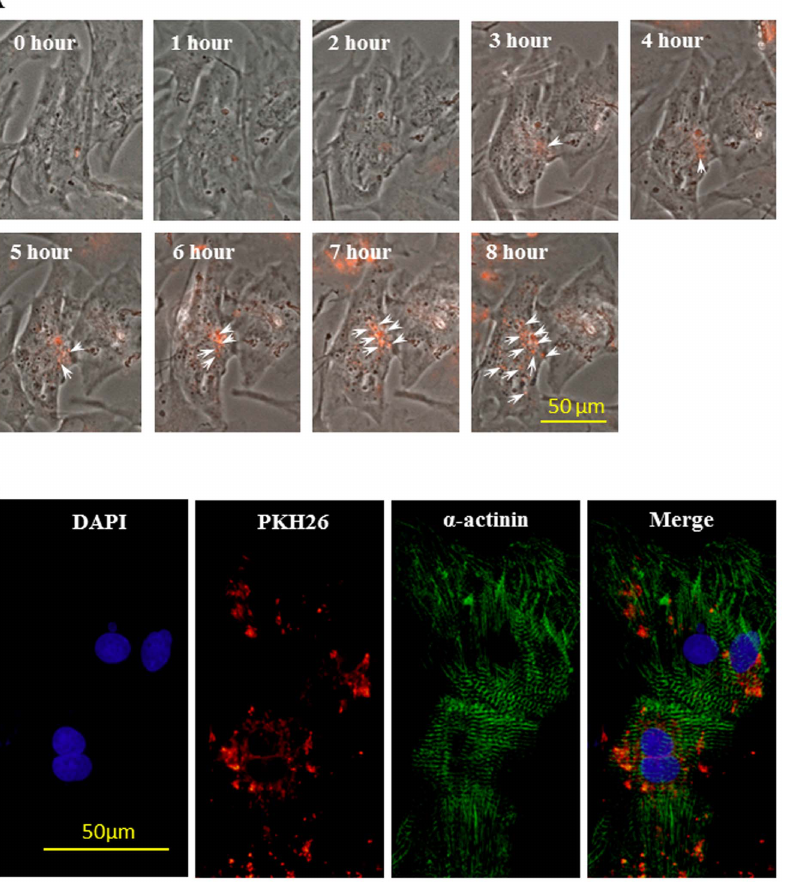
Figure 8. Internalization of PKH-26 pre-labeled MSC-MVs (MVs-PKH26) by CM. Panel A: Time-lapse images of MVs-PKH26 recorded at one hour intervals for 8 hours after addition of these MVs to CM culture. PKH26 red fluorescence (MVs) (white arrows) appeared inside CM at hour 3 and was widely scattered in whole cell clusters at hour 8. Panel B: Immunostaining shows internalization of MVs-PKH26 (red arrows) by a -actinin positive cells after MVs were added to CM cultures for 24 hours. doi:10.1371/journal.pone.0073304.g008 PLOS ONE |